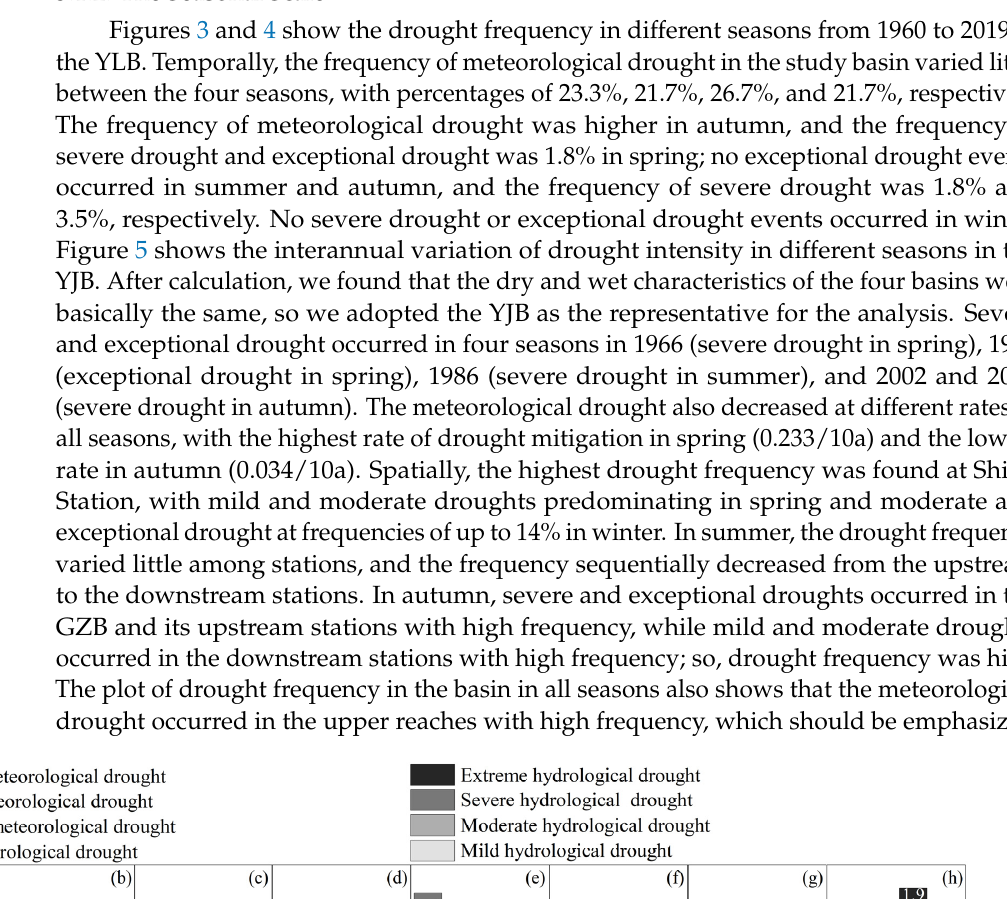
Figure 4. Interannual variation of drought intensity in different seasons in the YJB from 1960 to 2019. ( a – d ) indicate spring, summer, fall, and winter, respectively. 3.1.3. The Monthly Scale Due to the uneven distribution of precipitation, temperature, and wind speed within the year, the distribution of drought is regional and complicated, and the frequency of drought events varies from month to month. Most areas are prone to mild and moderate droughts, while severe and exceptional droughts are less frequent. Figure 5 reflects the monthly variation characteristics of drought frequency from 1960 to 2019 in YJB. Meteor- ologically, the frequency was as high as 57% for mild drought, 30% for moderate drought, and 13% for severe and exceptional droughts. The lowest drought frequency was 19.3% in December. The drought frequency reached 29.8% in April, August, and September, but exceptional drought events only occurred from March to May. The frequencies of severe